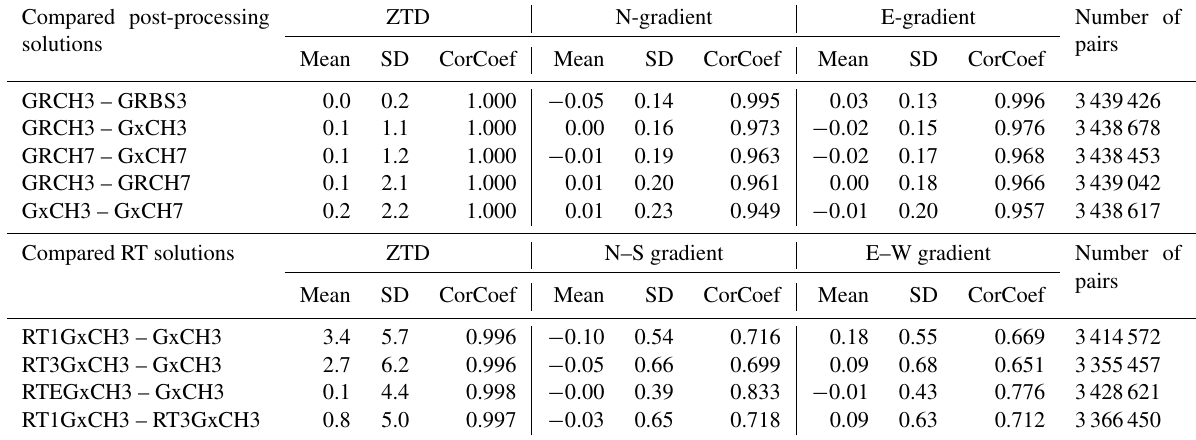
Table 4. Comparison of individual variants of the GNSS data processing run in post-processing mode (top) and in simulated real-time mode (bottom). Units: mean and SD in millimetres; CorCoef represents a linear correlation coefficient. Compared